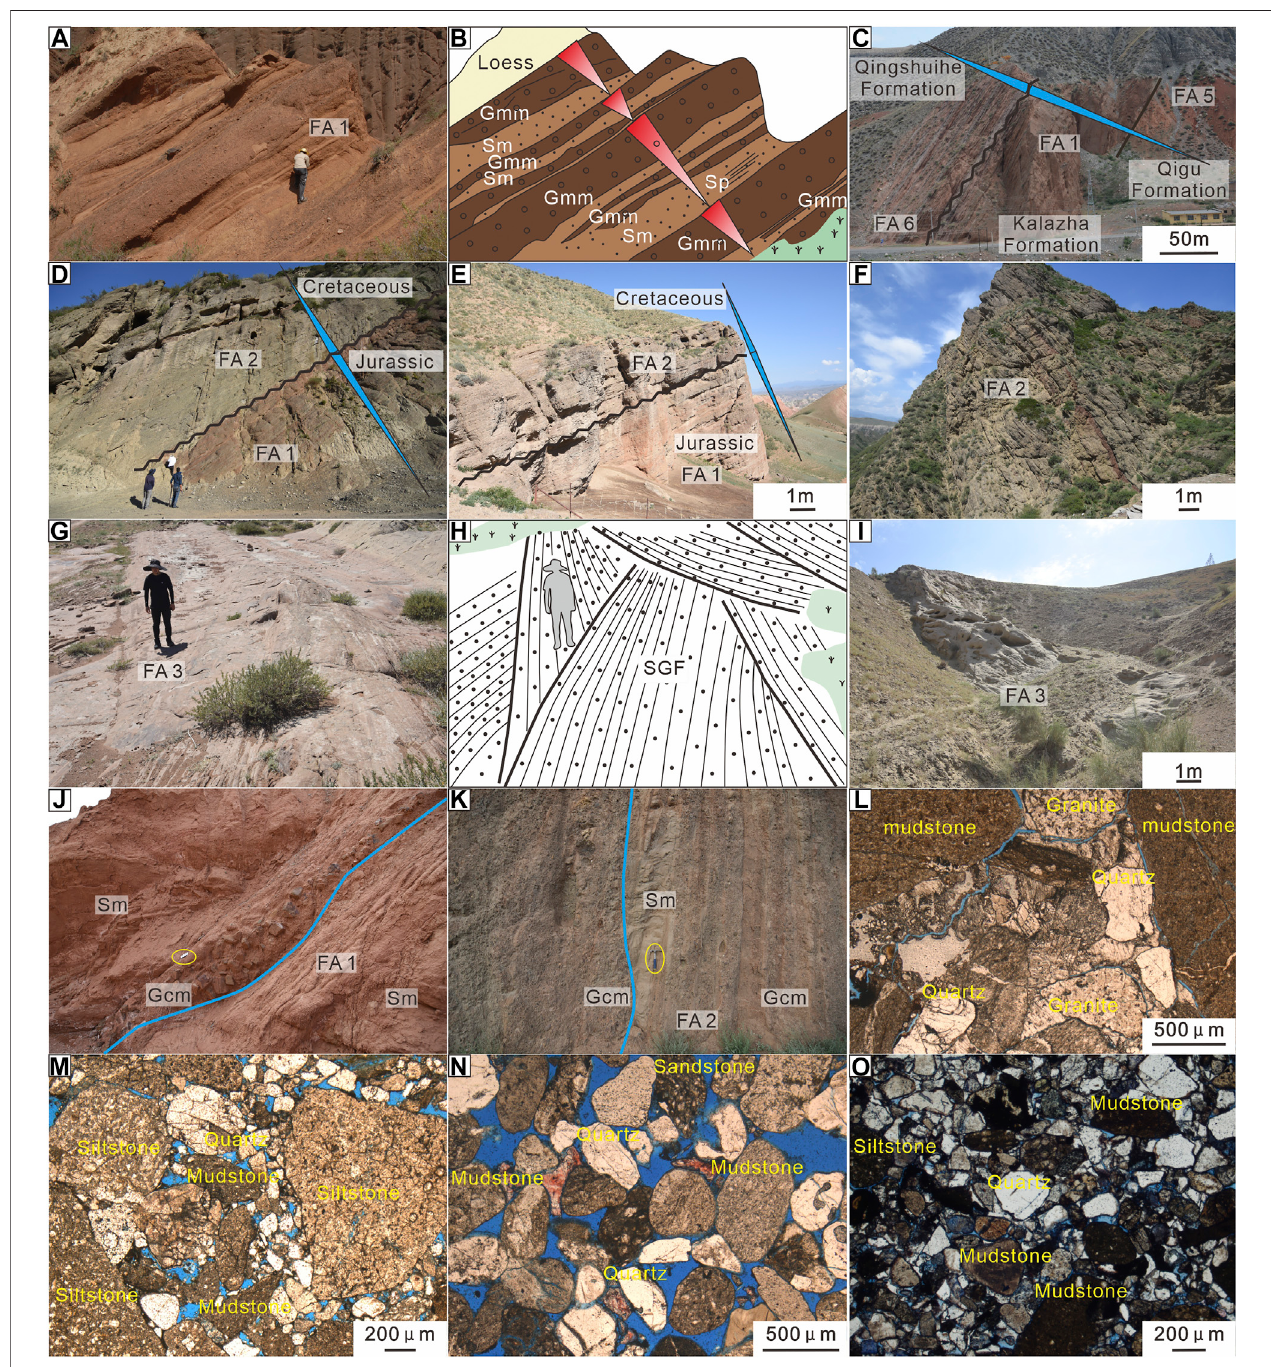
FIGURE 5 | Sedimentary characteristics of the Kalazha Formation in the northern piedmont of the Tianshan Orogenic Belt (a-f, l, m) and Bogda Orogenic Belt (g-k,n,o)intheSouthernJunggarBasin (A,B) Manasisection(Guanetal.,2020).Theman(170 cm)forscale; (C) SikeshuRiversection; (D) Quergousection(Guan et al., 2021). The man (175 cm) for scale; (E) Dongwoz section; (F) Jiangong mine section (G, H) Wangjiazhuang section. The man (175 cm) for scale; (I) Dahongshan section (J) Shuimohe section. The ruler for scale (K) Baiyanghe section. The hammer (27.9 cm) for scale (L) casting thin section, plane-polarized light,Manasisection (M) castingthinsection,plane-polarizedlight,Jiangongminesection (N) castingthinsectionwithAlizarinredS,plane-polarizedlight,Toutunhe River section. The Alizarin red S stained the calcite red (O) casting thin section, plane-polarized light, Baiyanghe section. FA-facies association. The de fi nition of facies associations see Table 2